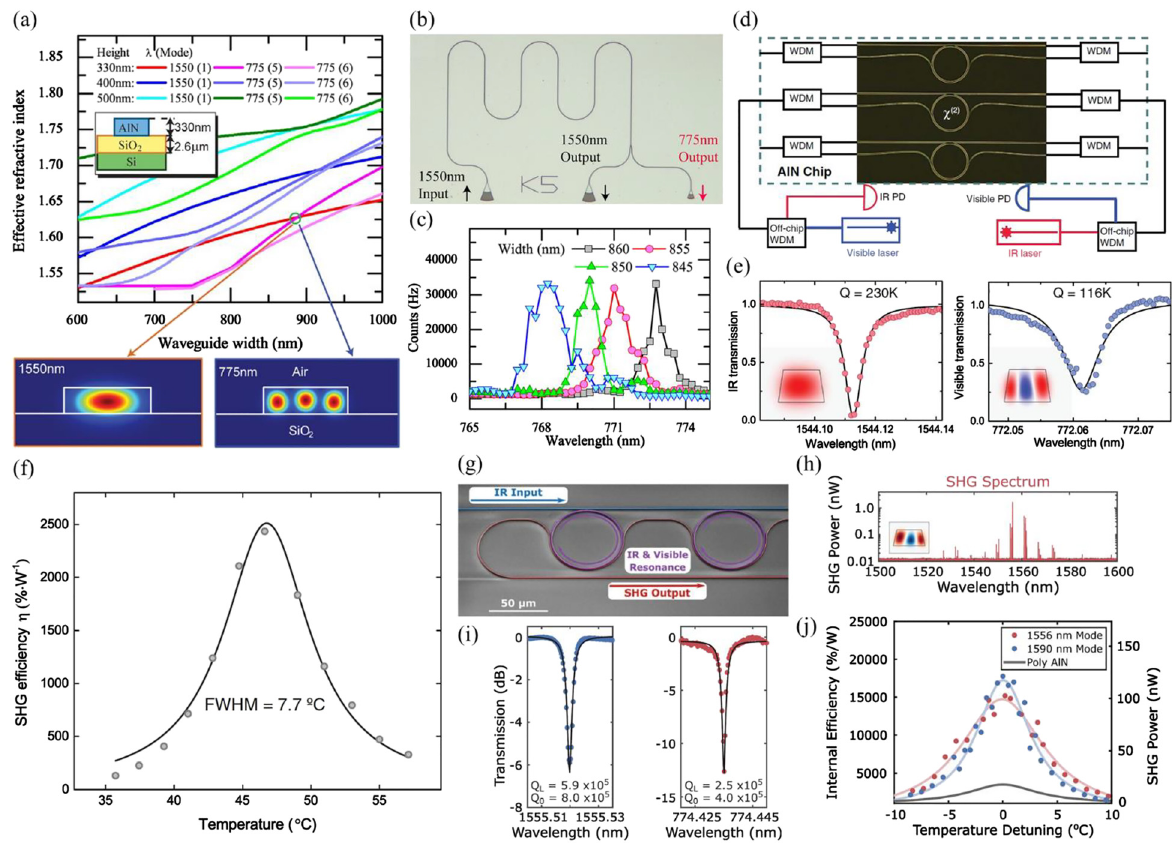
Figure 10: AlN-based integrated devices for second harmonic generation (SHG). (a) Calculated waveguide dispersion relation between the fundamental mode at 1550 nm and higher order modes at 775 nm. Phase matched condition can be ful fi lled at the cross-overpoint betweenthe dispersion curves at pump (1550 nm) and SHG wavelengths (775 nm),with mode pro fi lesincludedatthebottom.(b)OpticalimageoffabricatedwaveguideforSHG.(c)OpticalspectraofSHGsignalunderdifferentwaveguide width.(a) – (c)Adaptedfrom[54],withthepermissionofAIPPublishing.(d)SHGexperimentalsetup:off-chipwavelengthdivisionmultiplexers (WDM) are used to split/combine the pump signal at IR wavelength and SHG signal at visible wavelength. Two sets of waveguides are used to couplelightintoandout ofthemicroringcavityseparately, sothatthecriticalcouplingcanbeachievedforboth wavelengthssimultaneously. (e)Leftandright panel:cavity transmissionspectrumforthepumpwavelengthandSHG wavelength, withloaded Q of 2.3 × 10 5 and1.16 × 10 5 , respectively. TM 0 mode for pump and TM 2 mode for SHG signal are included as insets. (f) SHG ef fi ciency with respect to device temperature, with optimizedef fi ciencyof 2500%/Wachieved around46 ° C. (d) – (f) Adaptedwith permissionfrom [94] ©The OpticalSociety.(g)SEM image of fabricated AlN SHG device without top cladding layer. Pump light is coupled into the cascaded microring cavities through straight bus waveguide at top marked in blue. Within the microring cavity marked in purple, the phase-matching condition is achieved between the TM 0,0 mode at pumpwavelength in IR, andTM 2,0 mode at SHG signalin near-visiblewavelength. The wrap aroundwaveguidemarked inred couples the SHG signal in near-visible wavelength out from the microring and is connected to the on-chip WDM. (h) SHG spectrum captured at the output port after cascaded microrings. (i) Resonance spectra at pump (left panel) and SHG signal (right panel). The loaded Q factor for pump andSHGmodecanbeobtainedas 5.9 × 10 5 and2.5 × 10 5 ,respectively.(j)SHGef fi ciencyandpowerwithrespecttochiptemperaturedetuning for pump mode at 1590 nm (blue) and 1560 nm (red). Maximum SHG ef fi ciency can reach 17,000%/W for 1590 nm pump mode. The simulated data for polycrystalline-based AlN SHG device has also been plotted for comparison. (g) – (j) are from [96], with the permission of AIP